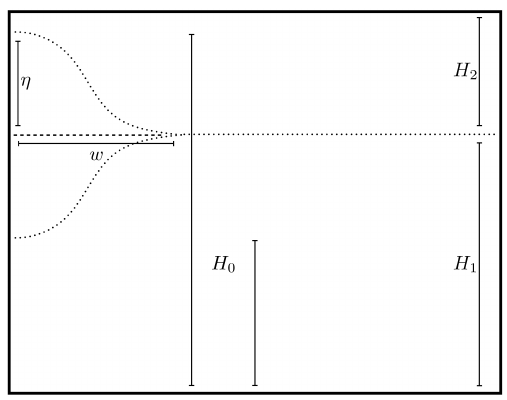
Figure 1. A schematic of the tank simulation set-up which illus- trates the different parameters. The dotted line represents the isopy- cnal found at the centre of the pycnocline on the far right of the domain. The largest deflection (both polarities are shown in the fig- ure) occurs at the left end point of the domain. H 1 and H 2 represent the depth of fluid below and above the centre of the undisturbed pycnocline respectively. H 0 is the maximum or minimum height of the pycnocline created by the initial conditions. η is the isopycnal displacement. w is the width of the initial condition defined from the left-hand wall to where the pycnocline reaches within 1% of the undisturbed